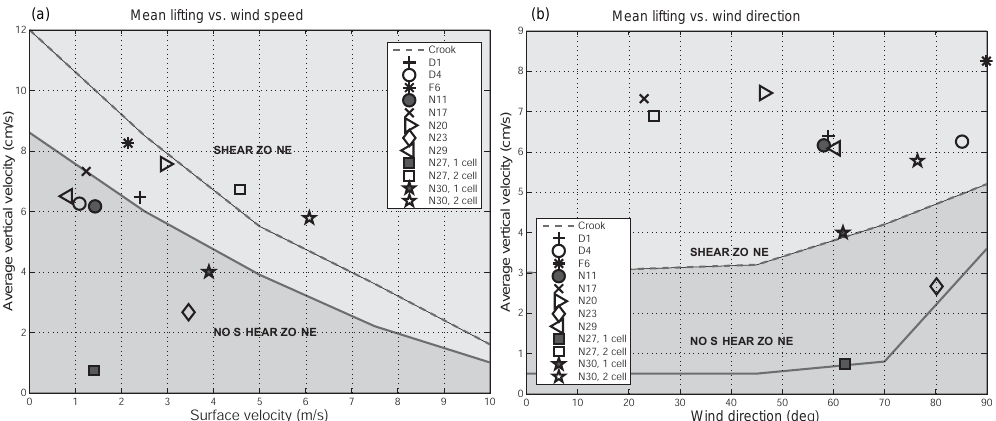
Figure 8. Crook’s test: panels (a) and (b) show vertical velocity at 500m extracted 3h before the maximum development versus surface wind speed (a) and surface wind direction (b) , both extracted at the start time. The figure reports two different regimes with a sheared (light gray, dashed line) and unsheared flow (dark gray, solid line) as studied by